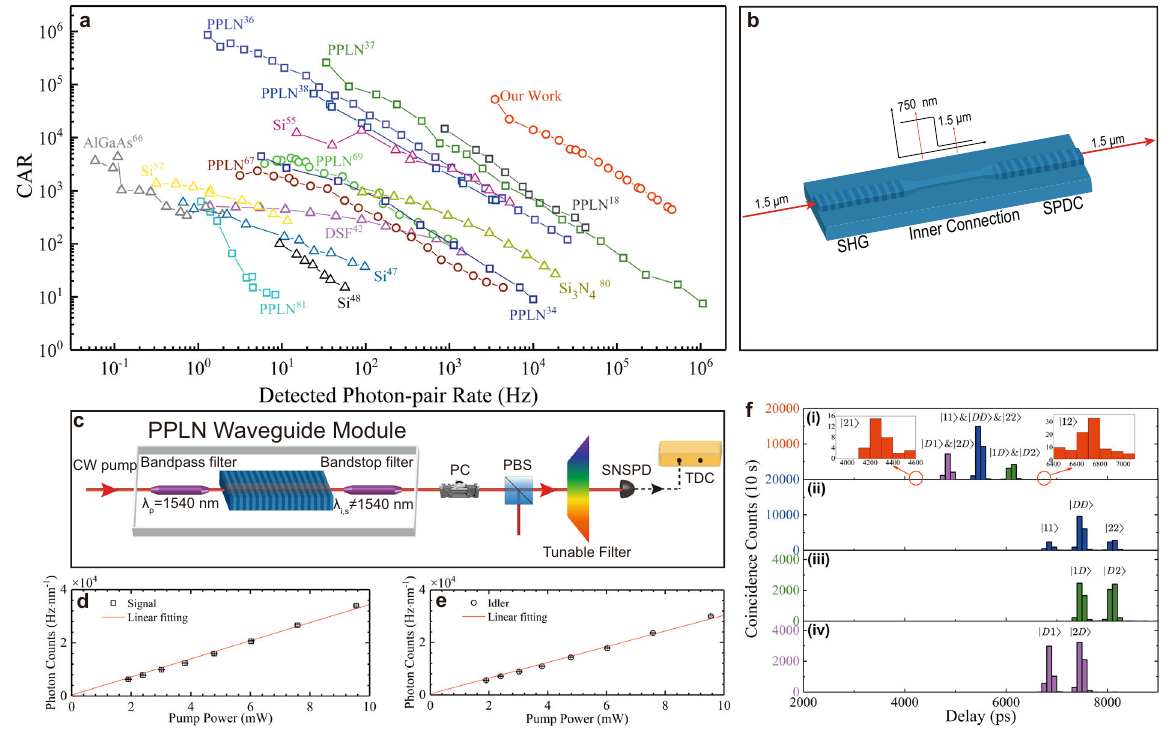
Fig. 5 The data, schematic, and experimental setup involved in sections “ Discussion ” and “ Methods ” . a A comparison of the CAR values and the detected photon-pair rate among the photon-pair sources in previous literature and our work. Ref. 80 is visible-telecom source, and others are all-telecom sources. The sources based on SFWM, SPDC, and cascaded SHG/SPDC processes are represented by triangles, rectangles and circles, respectively. b A scheme of a fully integrated structure for generating high-performance correlated/entangled photon-pairs by using cascaded SHG and SPDC processes. A inner waveguide is inserted between the SHG and SPDC regions to remove the residual pump light at 1.5 μ m. c Setup for the spectra measurement of SpRS noise photons and correlated photon-pairs. The PBS used in this setup is a cube, rather than a fi ber-coupled one, in order to avoid the dependence of splitting ratio on wavelength. d , e The pump power dependence of the noise photons at signal and idler wavelengths, respectively. All the error bars are estimated by Poissonian photon-counting statistics. f A set of typical histograms of two-fold and three-fold coincidence counts obtained in the quantum-state tomography of time-bin